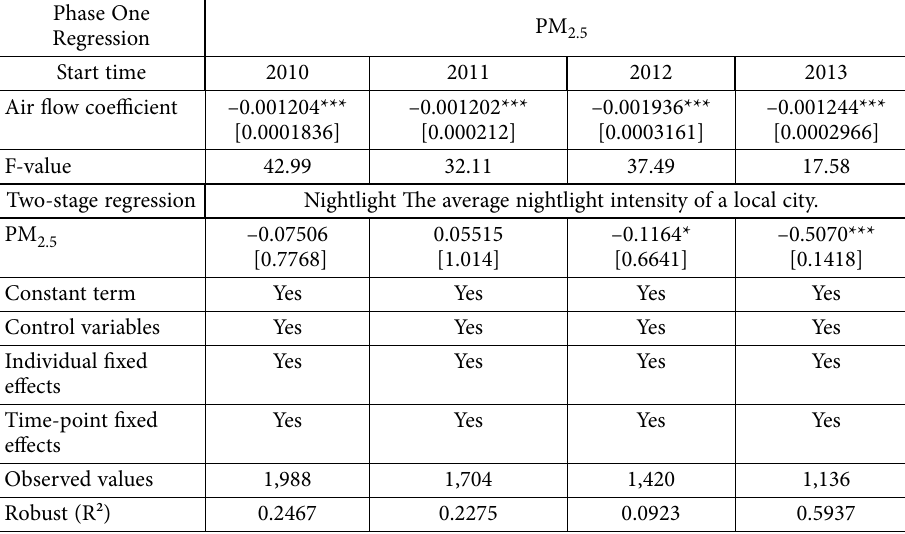
Table 8. Results of the time heterogeneity of air pollution and economic growth Phase One Regression